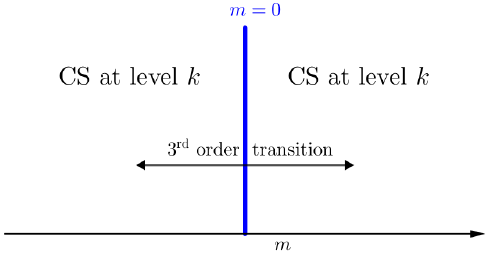
Figure 9 . Phase diagram of the theory with two opposite mass scales at | λ | → ∞ : two effective Chern-Simons theories are separated by a third order phase transition at m = 0